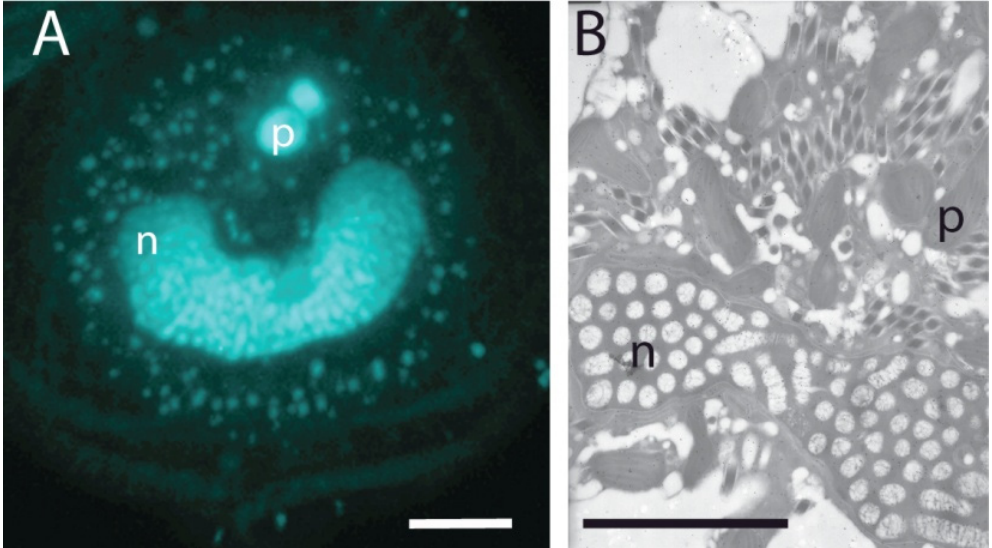
Figure 2. ( A ) Permanently condensed chromosomes of the dinoflagellate Lingulodinium polyedrum (the cultures were obtained from the National Center for Marine Algae, Maine) as visualized by fluorescence microscopy after DAPI. The C-shaped nucleus (n) is surrounded by the small punctate DNA staining of the multiple plastid genomes and lies under two larger spherical PAS bodies (p) at the apical end of the cell. ( B ) The nucleus viewed by transmission electron microscopy. The cross section shown lies near the back of the C-shaped nucleus (n) and shows chromosomes cut both in cross section (ovals) and longitudinally (cylinders), as well as plastids (p) and numerous diamond-shaped trichocysts. All scale bars are 10